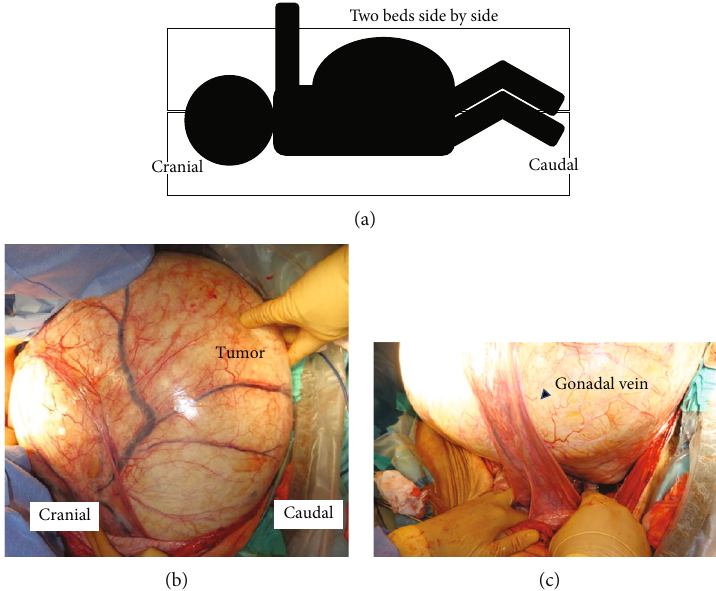
Figure 2: Intraoperative fi ndings in the laparotomy. (a) The surgery was performed in the left lateral recumbency position. (b) Most of the tumor was removed from the body without any adhesions between the tumor and the abdominal wall. (c) The right ovarian artery was found to be fl owing into the tumor.